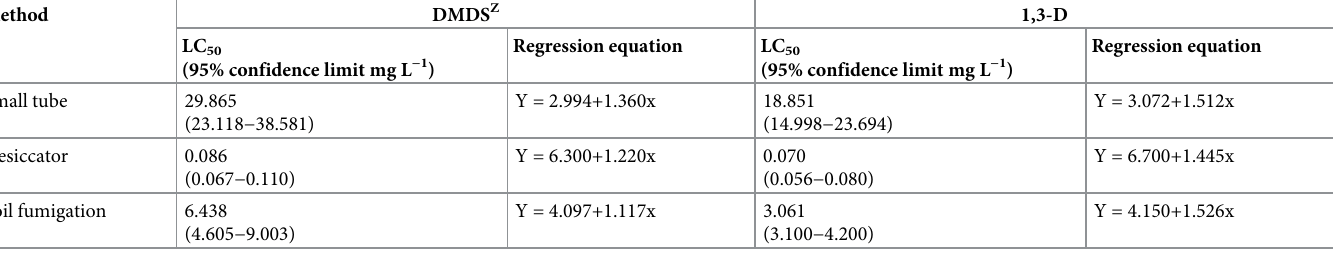
Table 3. Dose-response result of nematode on chemicals direct contact and fumigation activity and soil fumigation activity in small tube, desiccator, and soil fumi- gation methods.